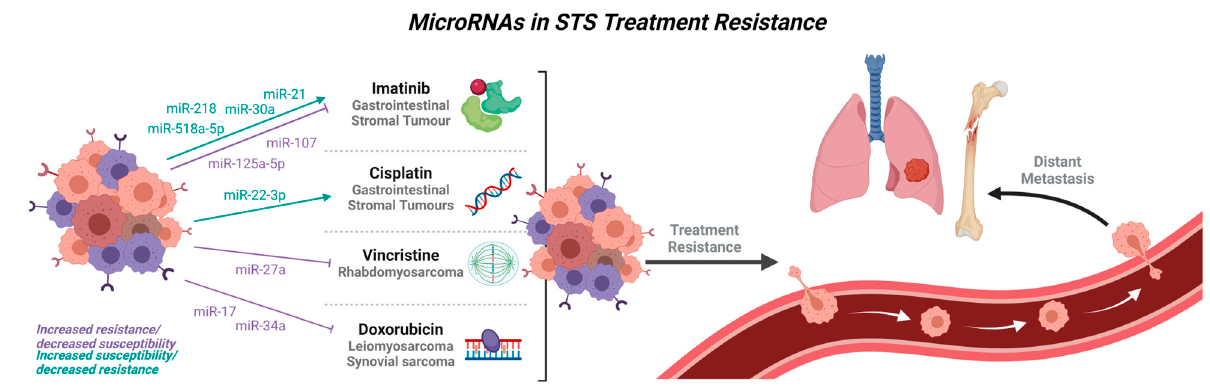
Figure 4. Known microRNAs implicated in treatment resistance of soft tissue